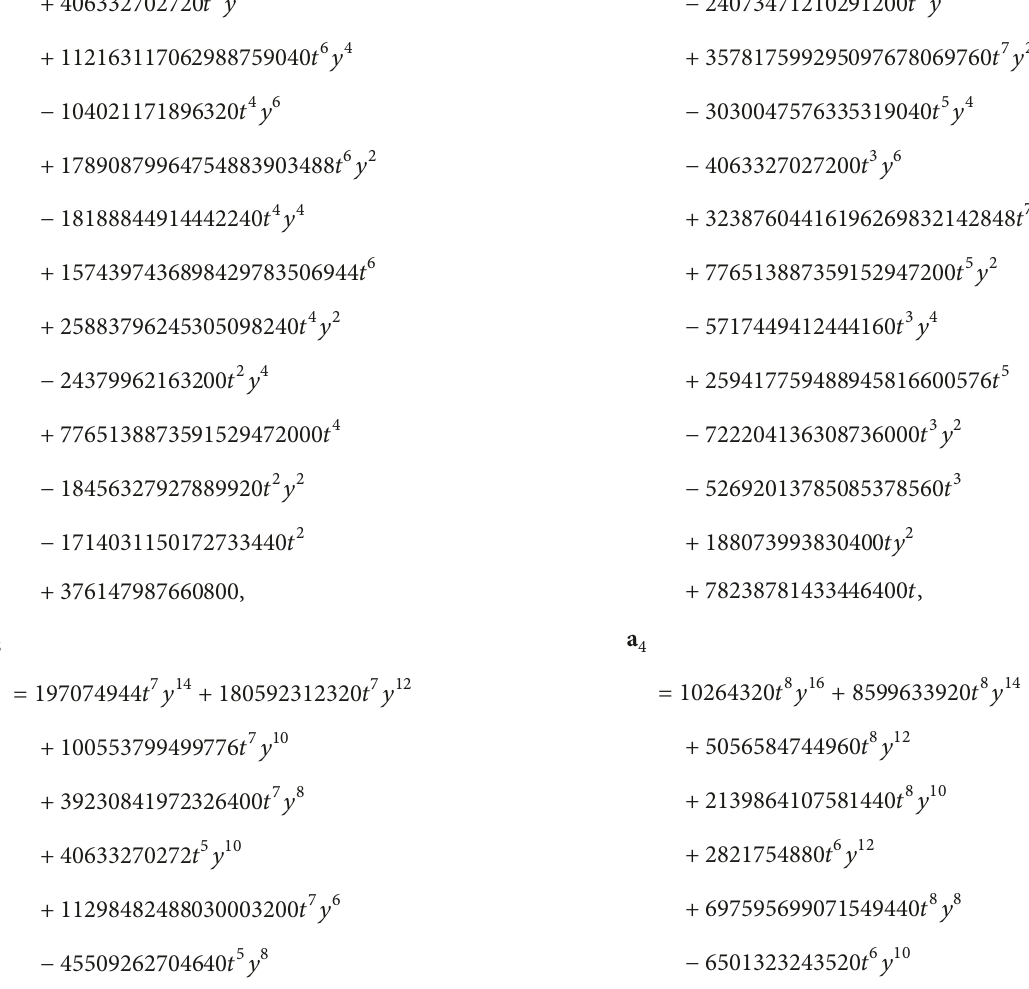
+ 406332702720𝑡 4 𝑦 8 + 112163117062988759040𝑡 6 𝑦